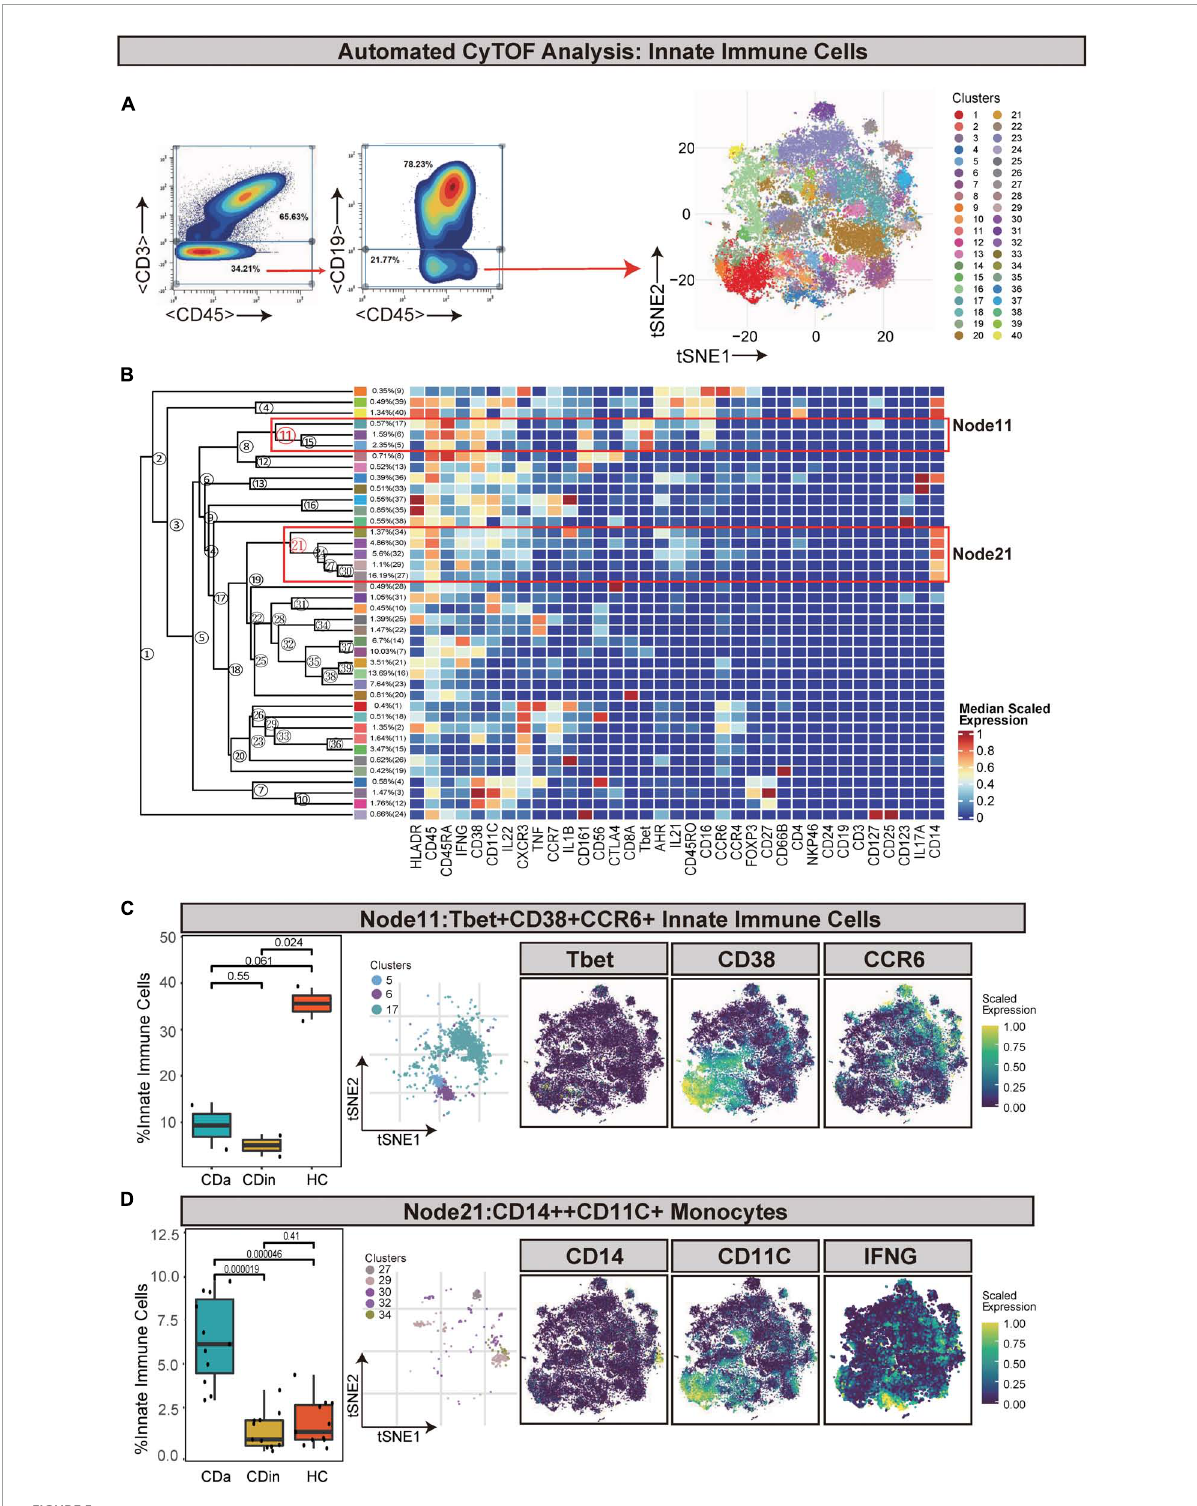
FIGURE5 CyTOF analysis showed differences in immune cells among CDa, CDin, and HC. (A) Gating strategy (left) and t-SNE projection (right) of innate immune cells derived from CyTOF data. (B) Cluster dendrogram and heatmap of innate immune cells. (C) The percentage of Node11 in innate immune cells among three groups (left) and the t-SNE plot of Node11 with gene expression feature plot for Tbet/CD38/CCR6 (right). (D) The percentage of Node21 in innate immune cells among three groups (left) and the t-SNE plot of Node21 with gene expression feature plot for CD14/CD11c